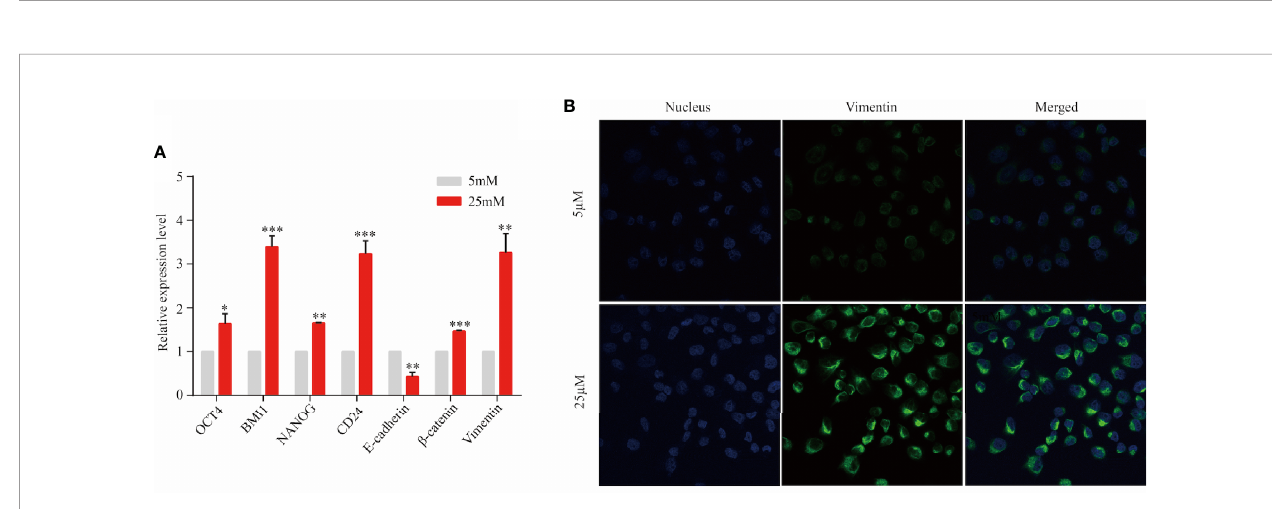
FIGURE 5 | KRAS -mutant tumor cells might transform into stem-like cells. Panc1 cells were cultured for 3 days in the presence of 5 or 25 µM of dextrose. (A) The expression level of OCT4, BMI1, NANOG, SOX2, CD24, E-cadherin, b -catenin, and vimentin was detected by RT-PCR. Data are presented as mean ± SEM of three independent experiments. (B) Vimentin expression was analyzed by immuno fl uorescent staining (blue, nucleus; green, vimentin). Original magni fi cation ×600. * p < 0.05, ** p < 0.005, *** p <